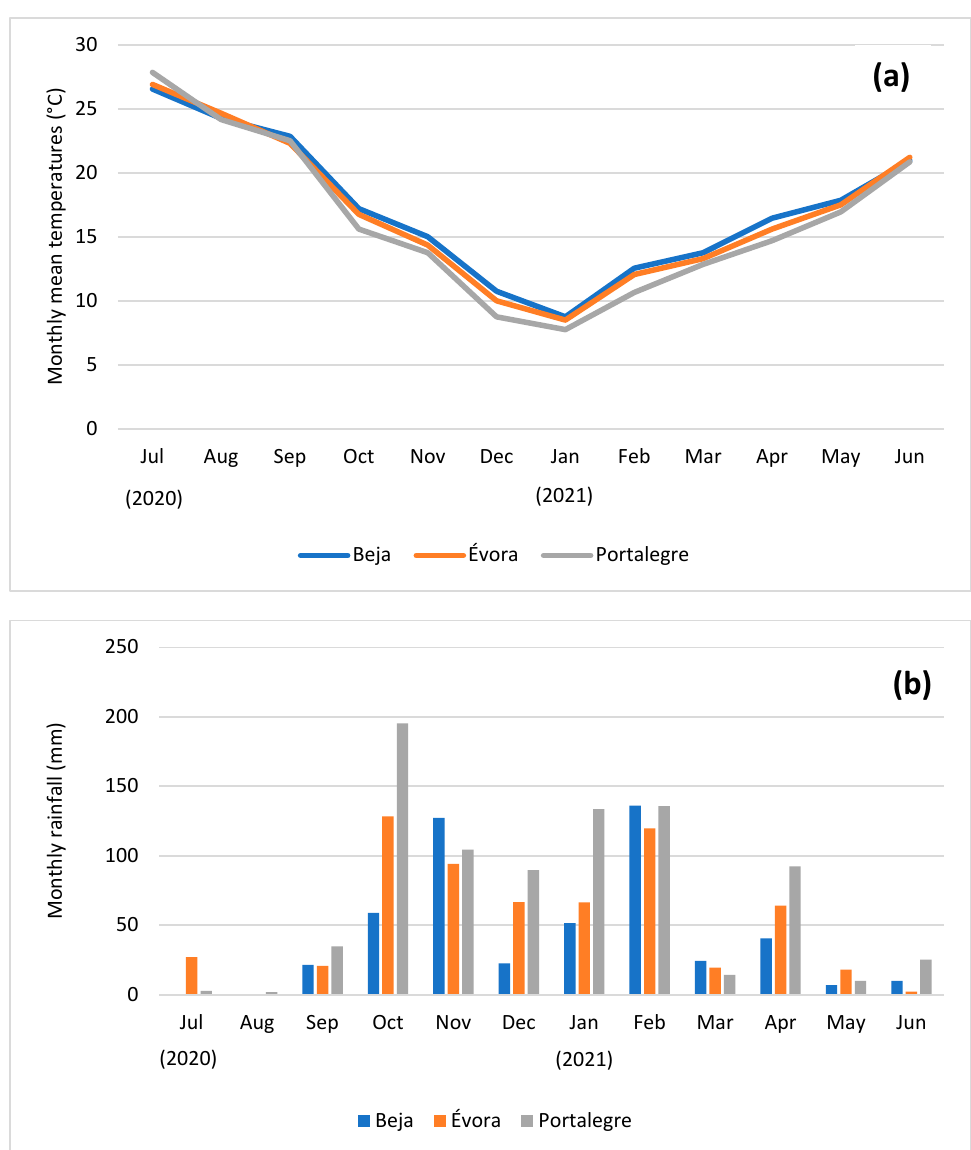
Figure 3. Thermopluviometric graphic for the districts of Beja, Évora and Portalegre between July 2020 and June 2021 (source: Portuguese Institute of Sea and Atmosphere). ( a ) Monthly mean temperatures ( b ) monthly rainfall.